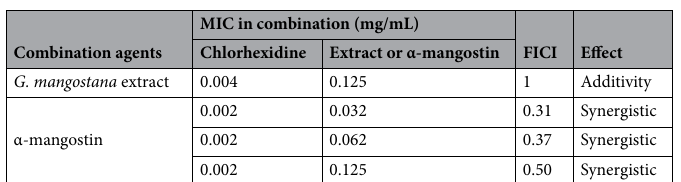
Table 2. Fractional inhibitory concentration index (FICI) of the combination test in targeting A. triangularis trophozoites.